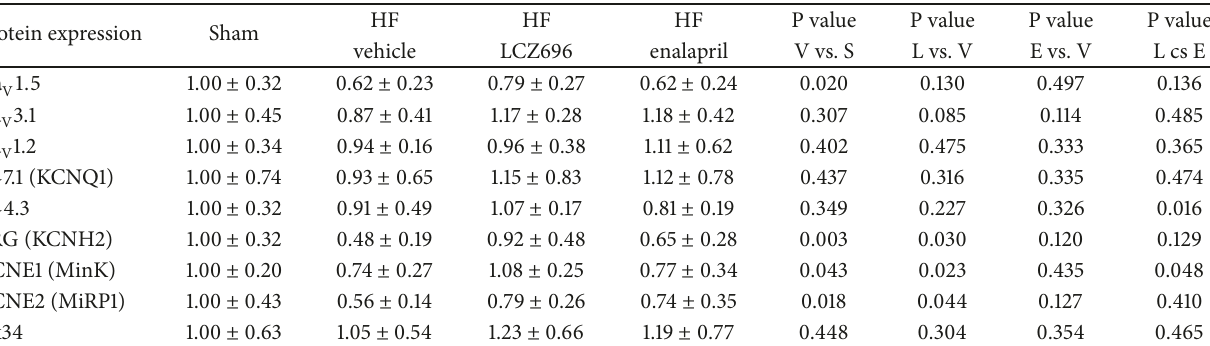
Figure 3:Results of electrophysiology exams. (a)Representative examples of echocardiographyexams. (b) Summarized resultsof PR interval, QRS duration, corrected QT interval (QTc), ventricular effective refractory period (VERP), and ventricular arrhythmia (VA) inducibility. Groups abbreviations: S, Sham; V, vehicle; L, LCZ696; E enalapril. Table 2: Protein